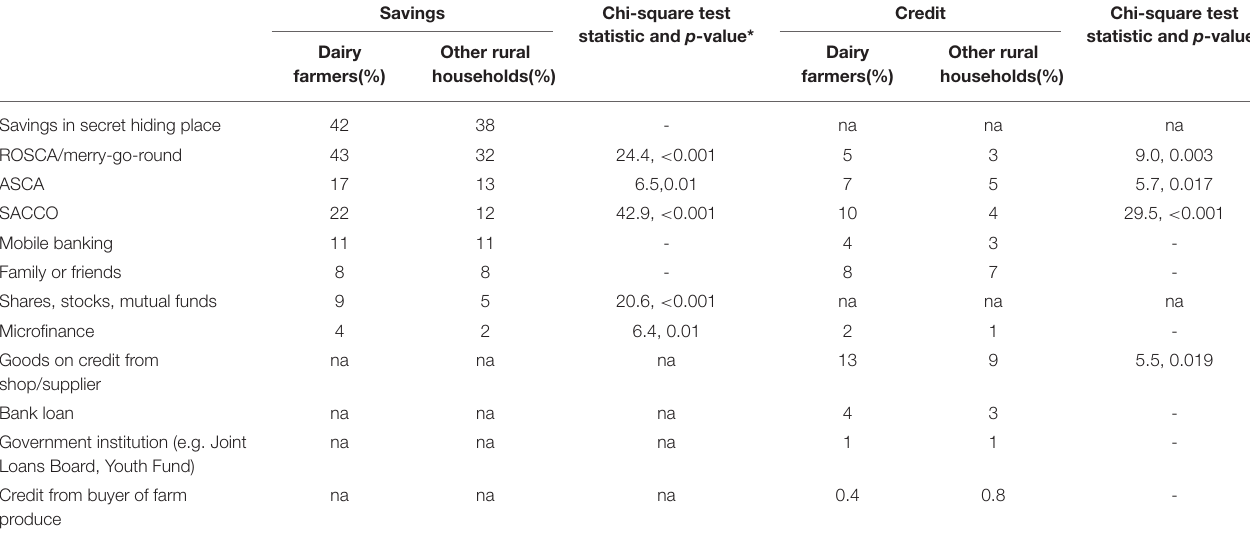
TABLE 3 | Proportion of dairy farmers ( n = 608) and other rural households ( n = 2,467) using different institutions for savings and loans, 2015.